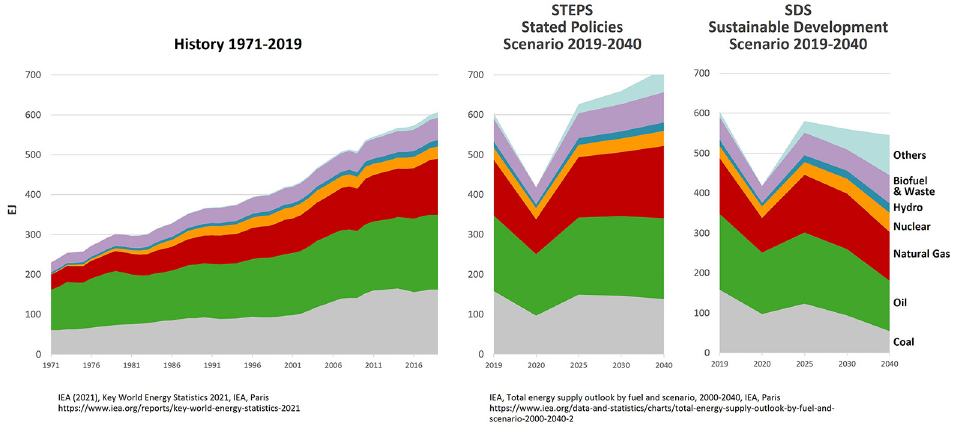
Fig. 15. – World energy supply by source, 1971–2019 and predicted 2019–2040 (Source: Inter- national Energy Agency,